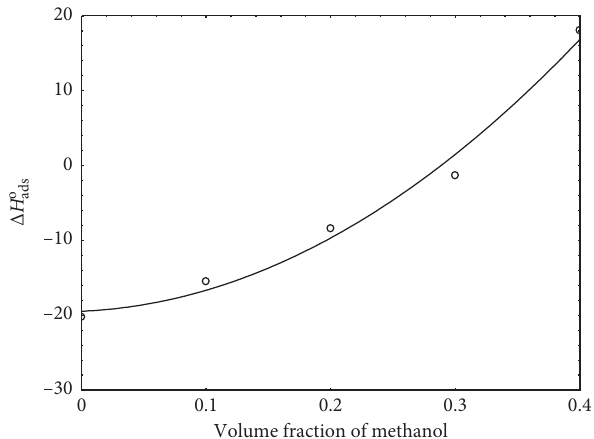
Figure 8: Variation in Δ H o